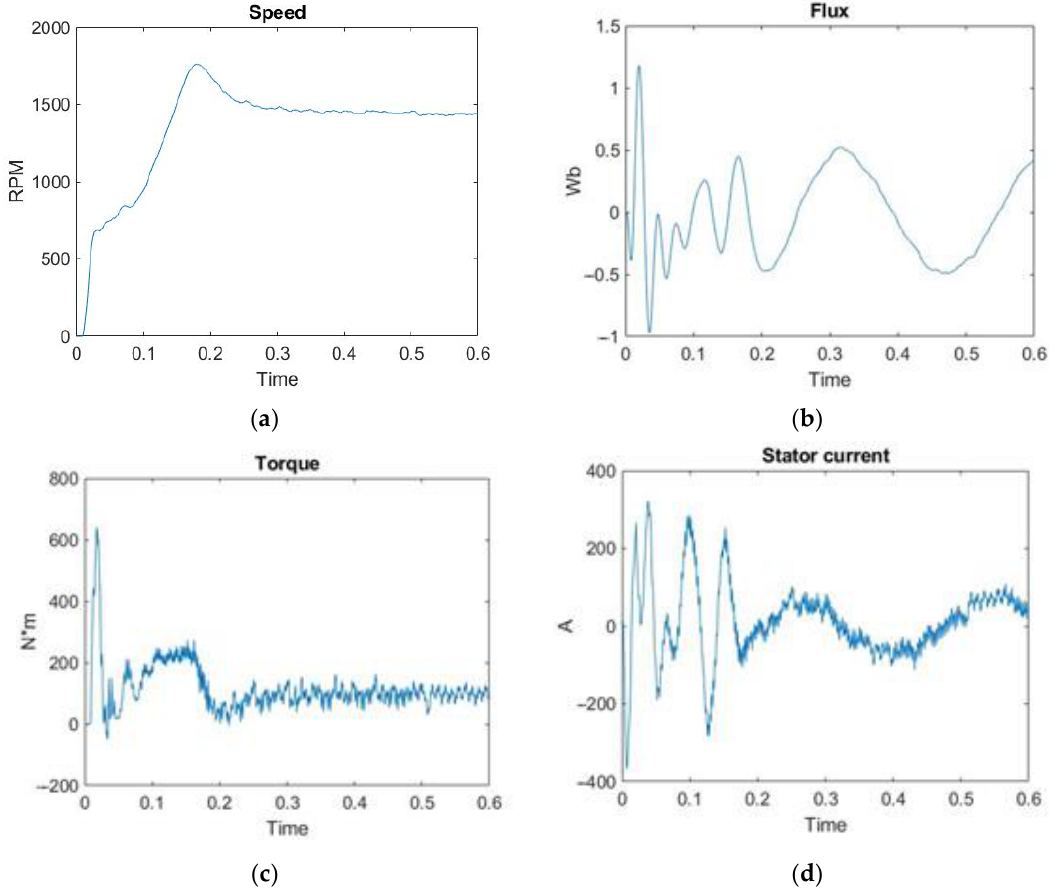
Figure 15. Output characteristics of induction motor: ( a ) speed; ( b ) flux; ( c ) torque and ( d ) current.